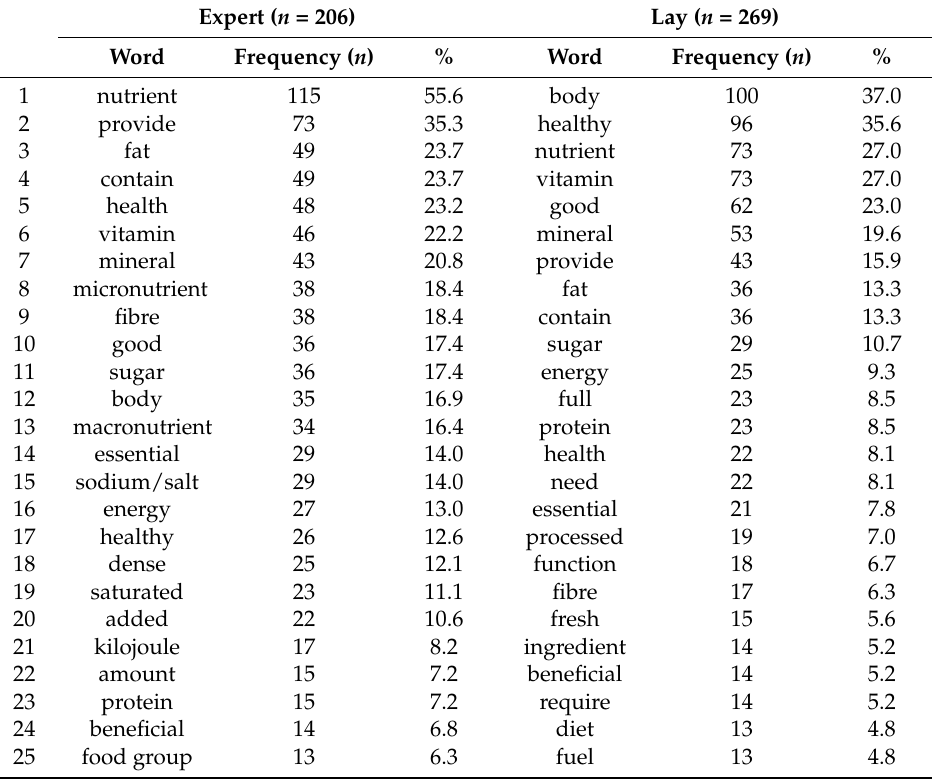
Table 1. Word frequencies in lay and expert